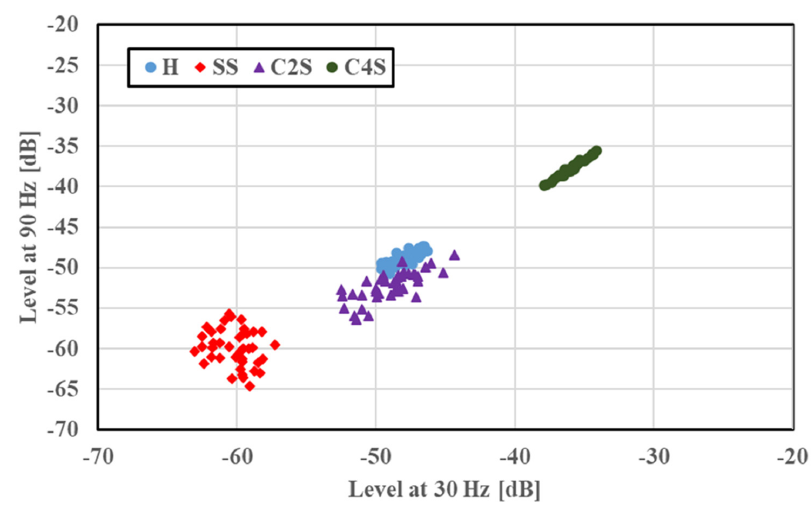
Figure 6. Feature distribution of concentrated scratches at 1765 min − 1 .